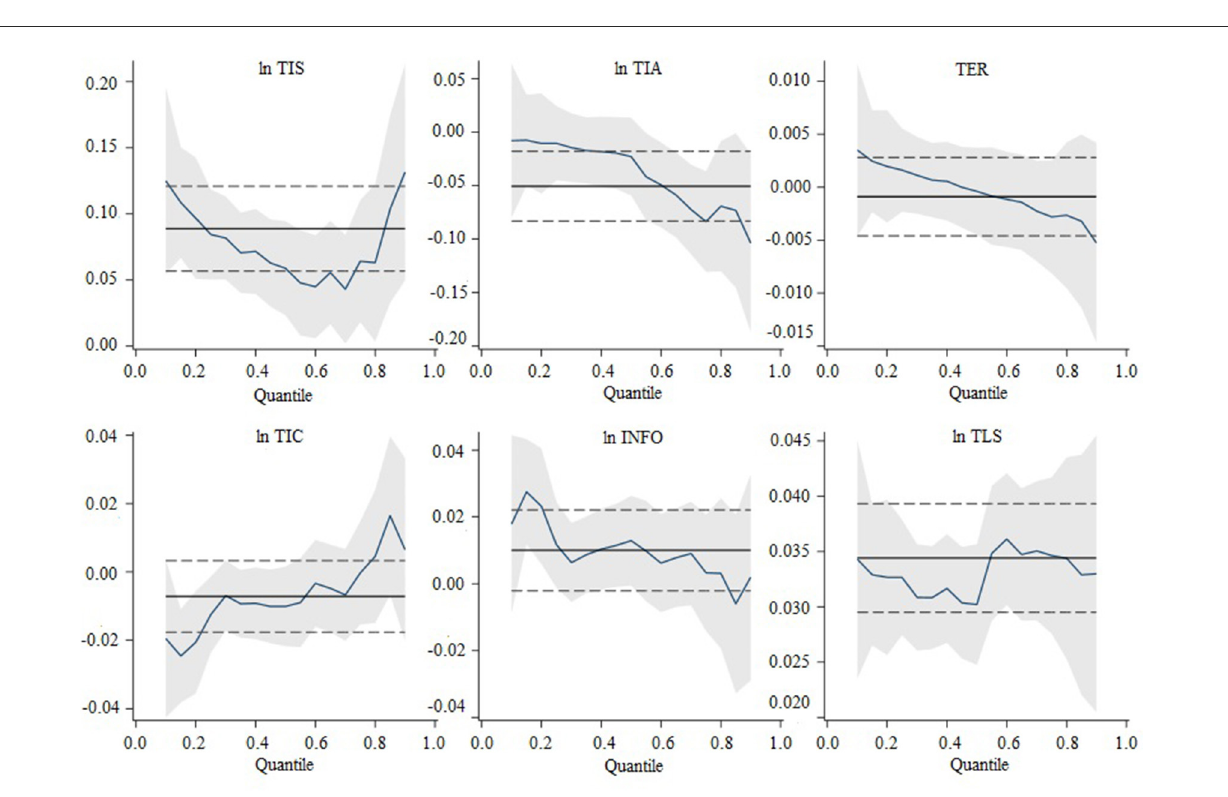
FIGURE4 Changes in quantile regression coefficients for tourism ecosystem health.